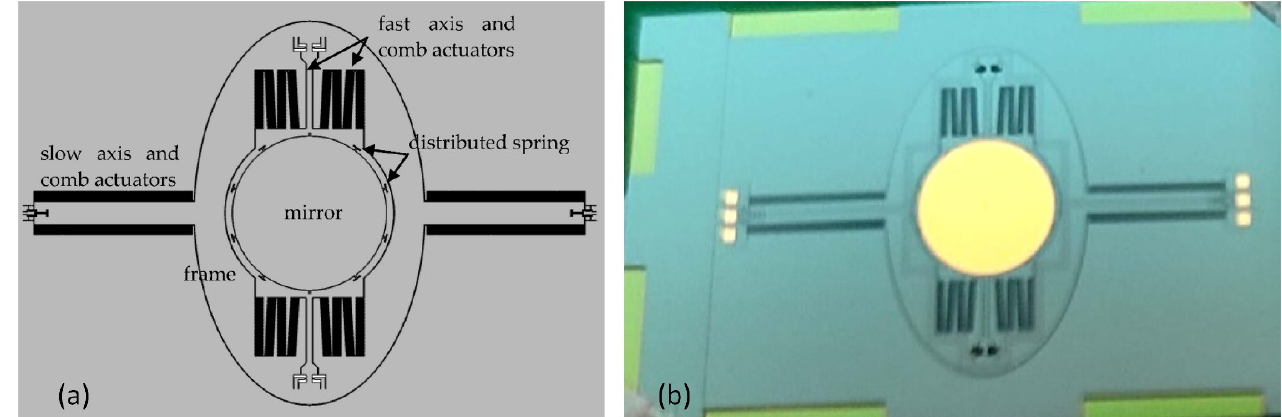
Figure 18. Scheme of the scanner: ( a ) layout of the scanner; ( b ) picture of the prototype. Adapted from [115].